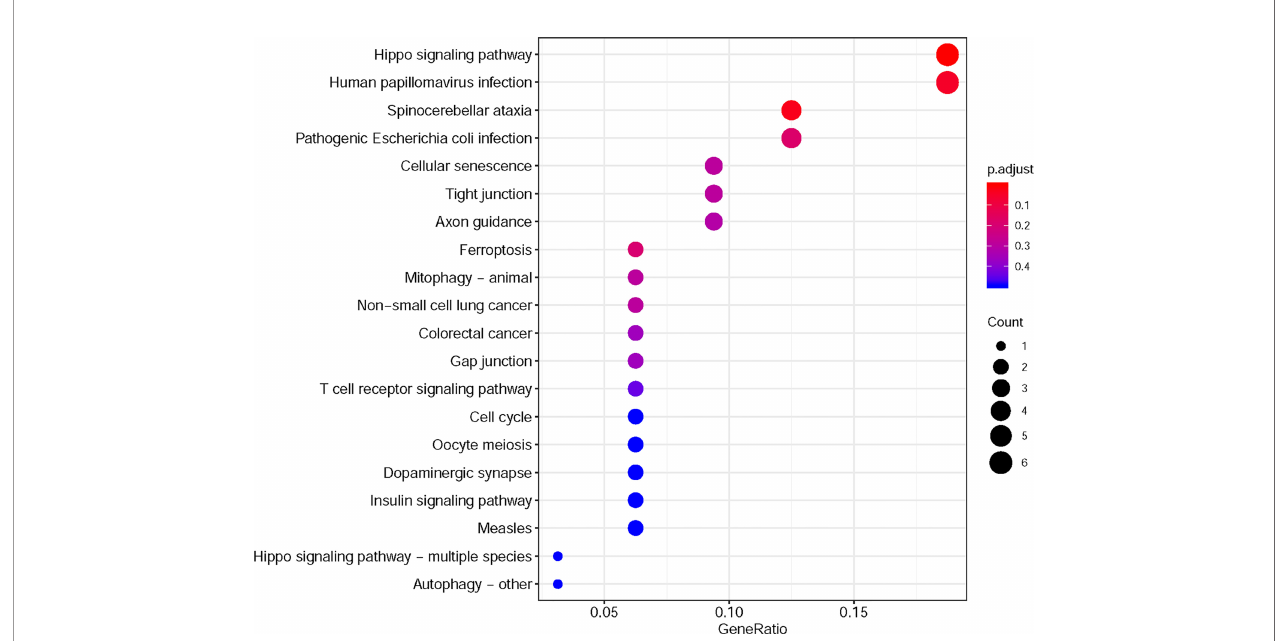
FIGURE 9 | KEGG pathway analysis tool was utilized to analyze the predicted pathways of MAP mutations and their 50 frequently altered neighbor genes via the DAVID dataset. DAVID, Database for Annotation, Visualization, and Integrated Discovery; KEGG, Kyoto Encyclopedia of Genes and Genomes; MAP, microtubule- associated